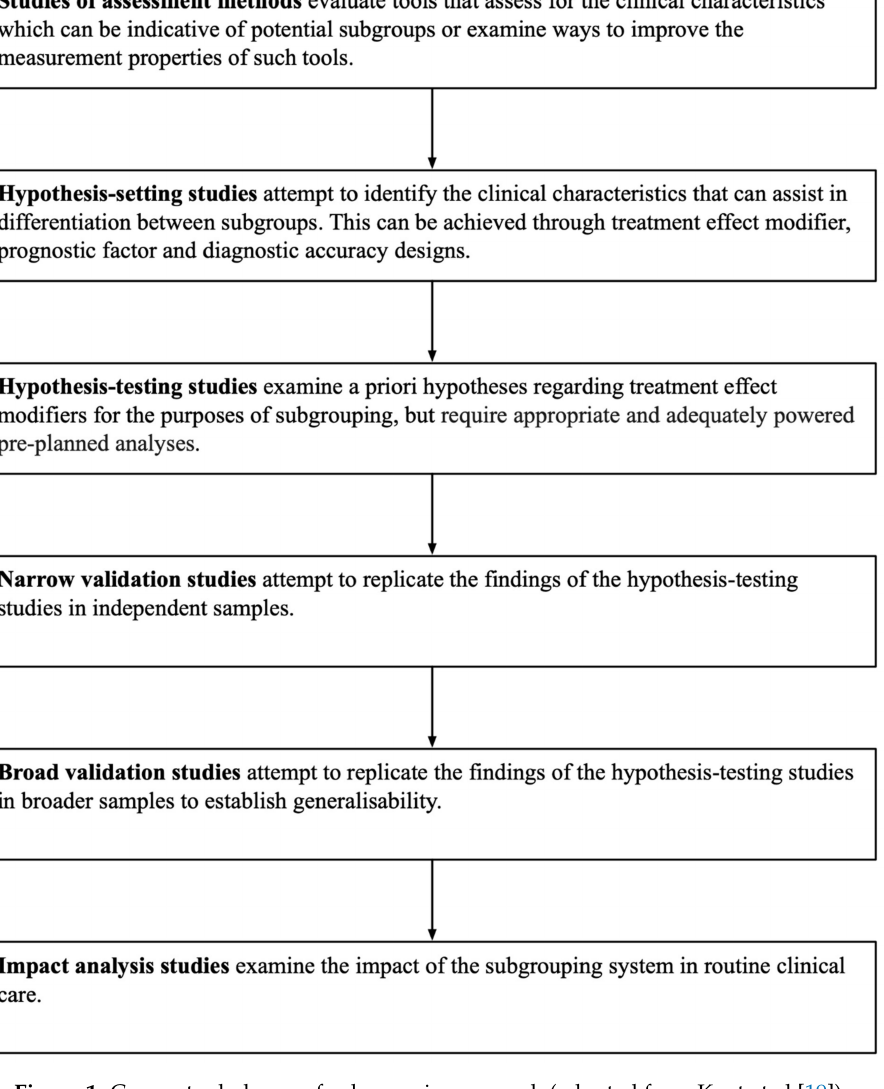
Figure 1. Conceptual phases of subgrouping research (adapted from Kent et al